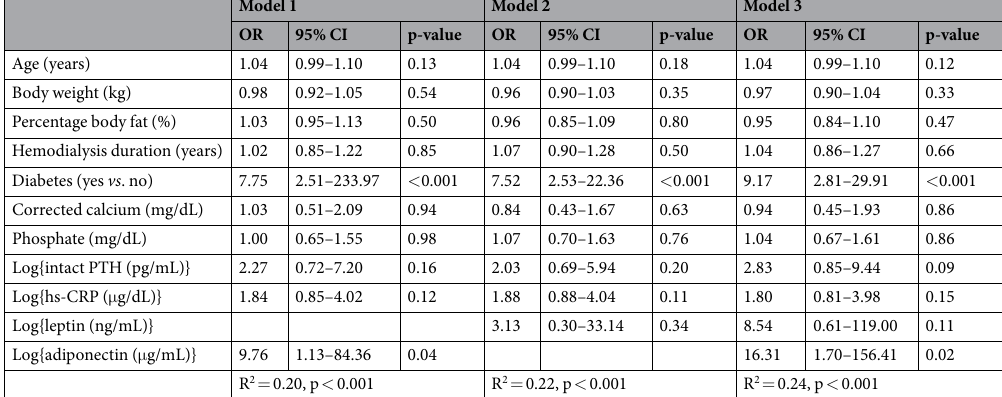
Table 2. Multiple logistic regression analysis of factors associated with AAC. AAC: abdominal aortic calcification, OR: odds ratio, 95% CI: 95% confidence intervals, PTH: parathyroid hormone, hs-CRP: high- sensitivity C-reactive